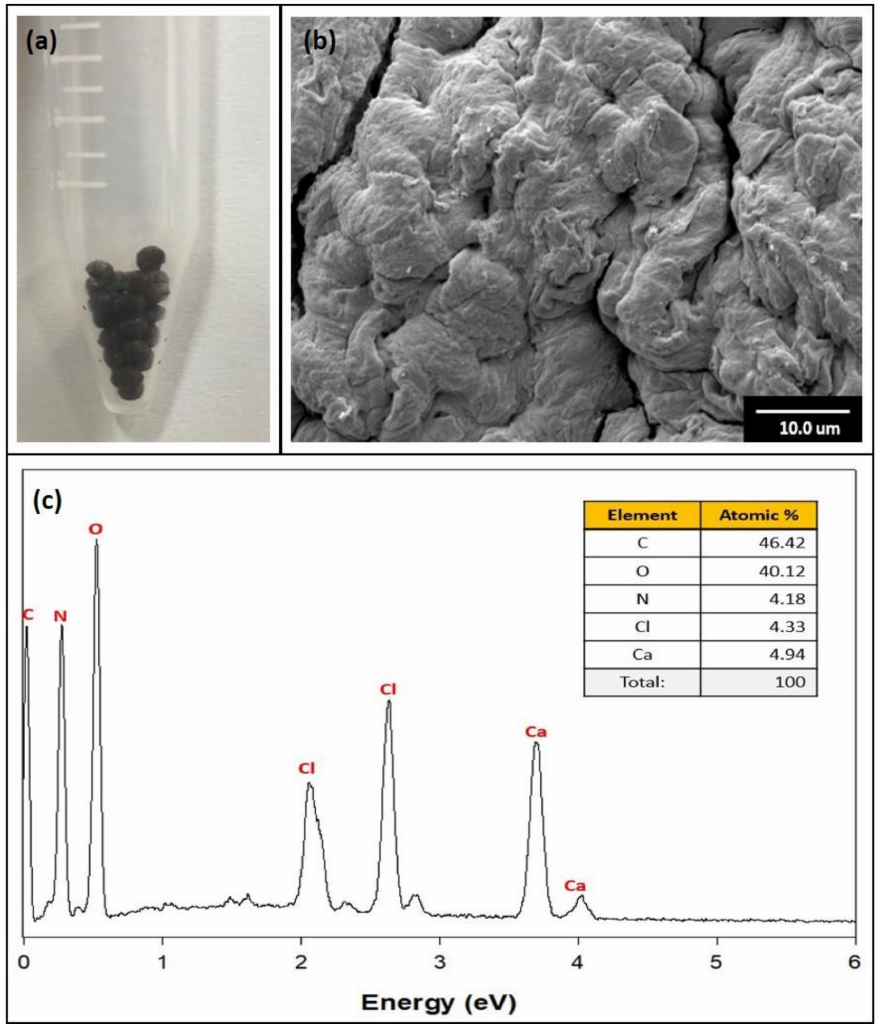
Figure 2. ( a ) GO/Ca-Alg 2 –PAM beads, ( b ) scanning electron microscopy image, and ( c ) scanning electron microscopy and energy dispersive X-ray spectroscopy